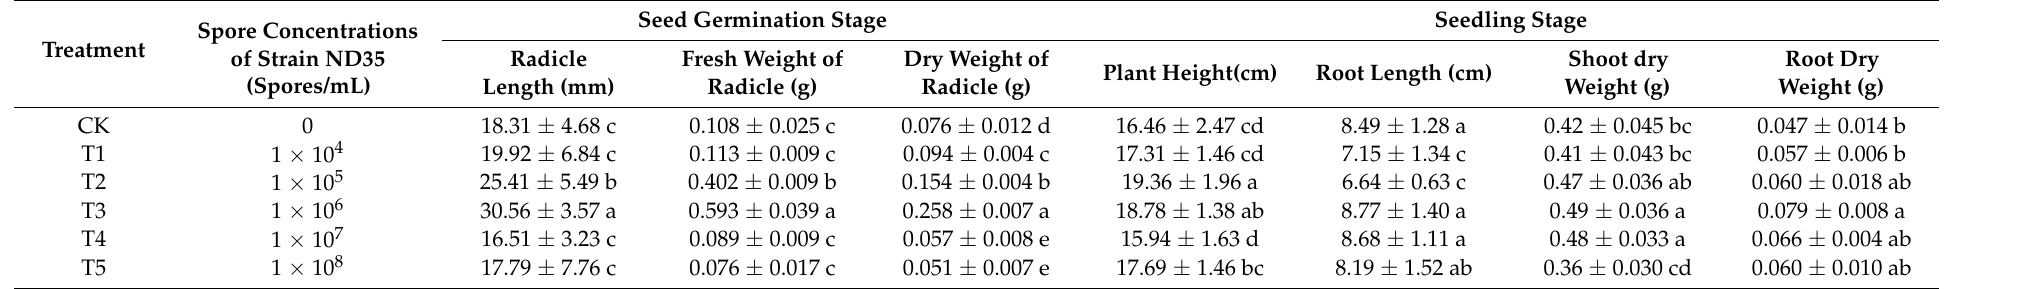
Table 1. Effect of C. globosum strain ND35 on the seed germination and seedling growth of cucumber.